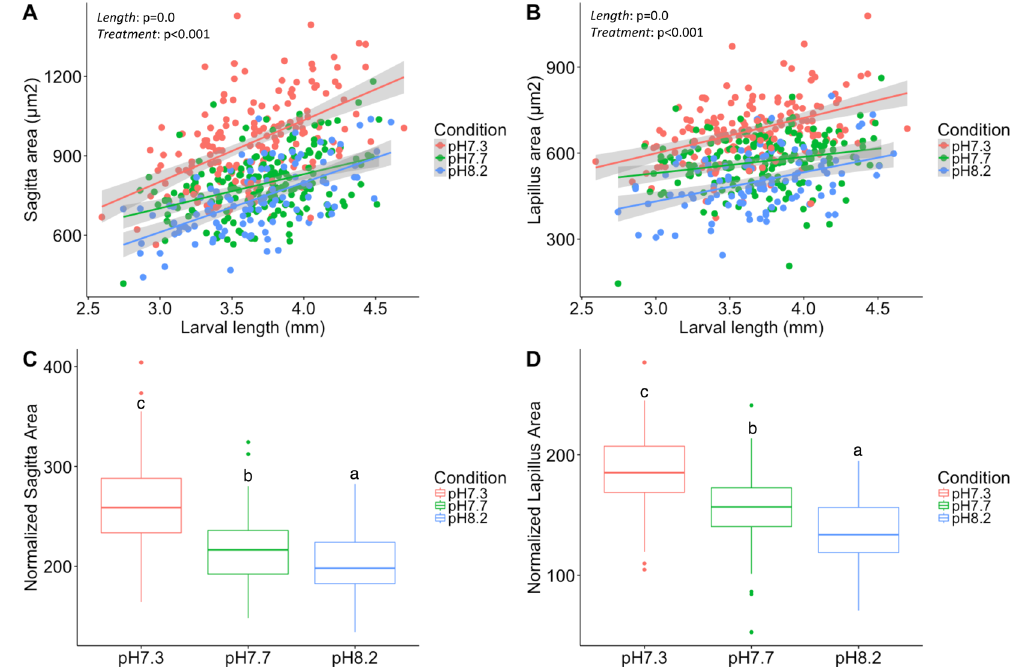
Figure 1. Correlation between otolith average area and larval body length in response to pH treatments. Larval total body length plotted against average sagittal ( A ) and lapillus ( B ) areas from animals exposed to pH7.3 (red circles), pH7.7 (green circles) and pH8.2 (blue circles). Correlations are indicated as red (pH7.3), green (pH7.7) and blue (pH8.2) lines; 95% confidence intervals are highlighted in grey around the linear correlation. Boxplot of normalized sagittal area ( C ) and normalized lapillus area ( D ) for pH7.3 (red box), pH7.7 (green box) and pH8.2 (blue box). Level of significance for pH treatment and animal length factors are indicated for each correlation. Different letters indicate significant differences between treatments (p < 0.05).